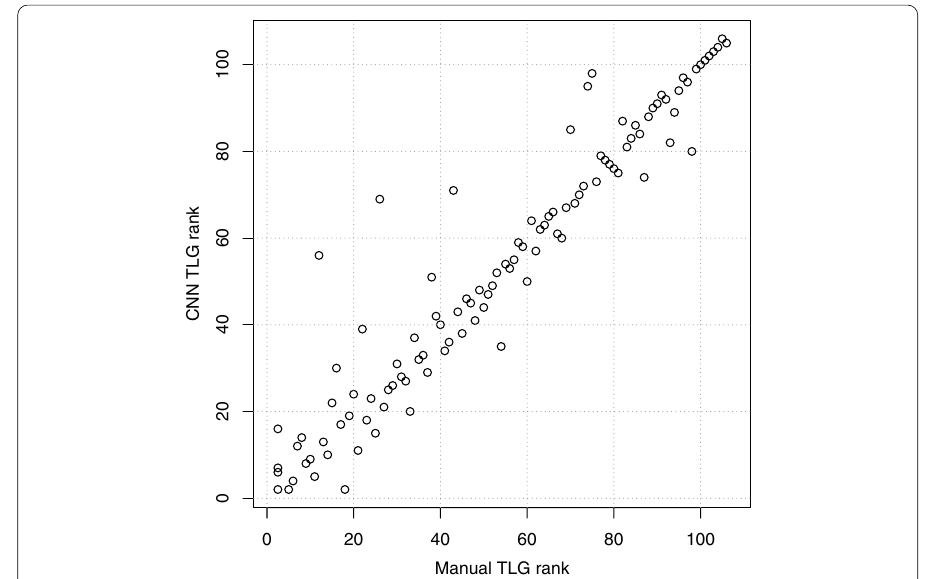
Fig. 2 The rank of each study based on manual TLG measurements against the rank of each study based on the CNN-based measurements. This serves to show, that in terms of ranking patients with respect to tumour burden the automated method is similar to a manual analysis